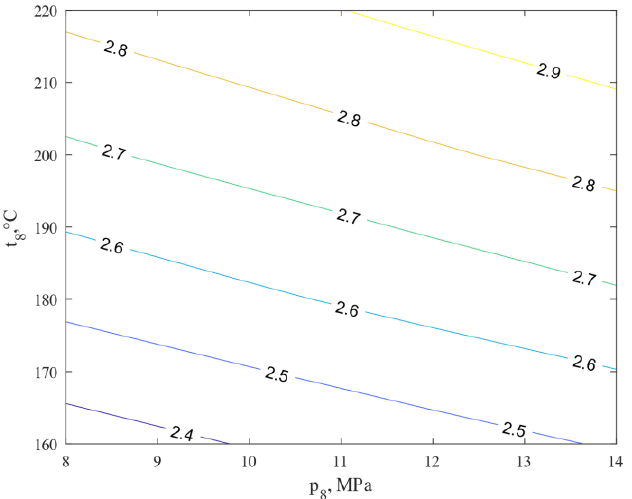
Figure 5. Influence of changes in pressure p 8 and temperature t 8 at the reactor inlet (Figure 3) on the total power of compressors ΣN c in kW.